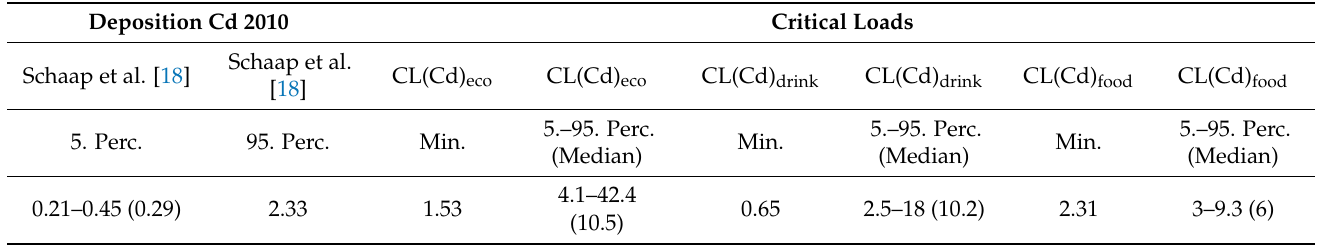
Table 7. Comparison of the Cd deposition (in g ha − 1 a − 1 ) with the assessment values (in g ha − 1 a − 1 ) and statistical evaluation of the area share of protected receptor areas in Germany, 2010, against limit values exceeded.